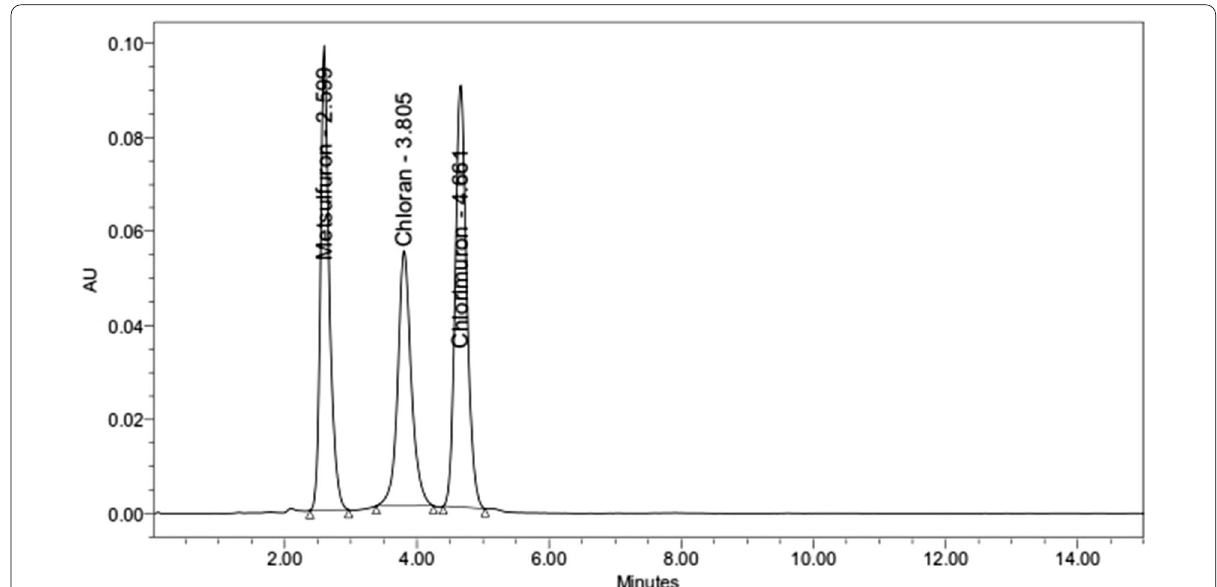
Fig. 7 Chromatogram showing the resolution of metsulfuron-methyl, chlorantraniliprole and chlorimuron-ethyl in standard solution